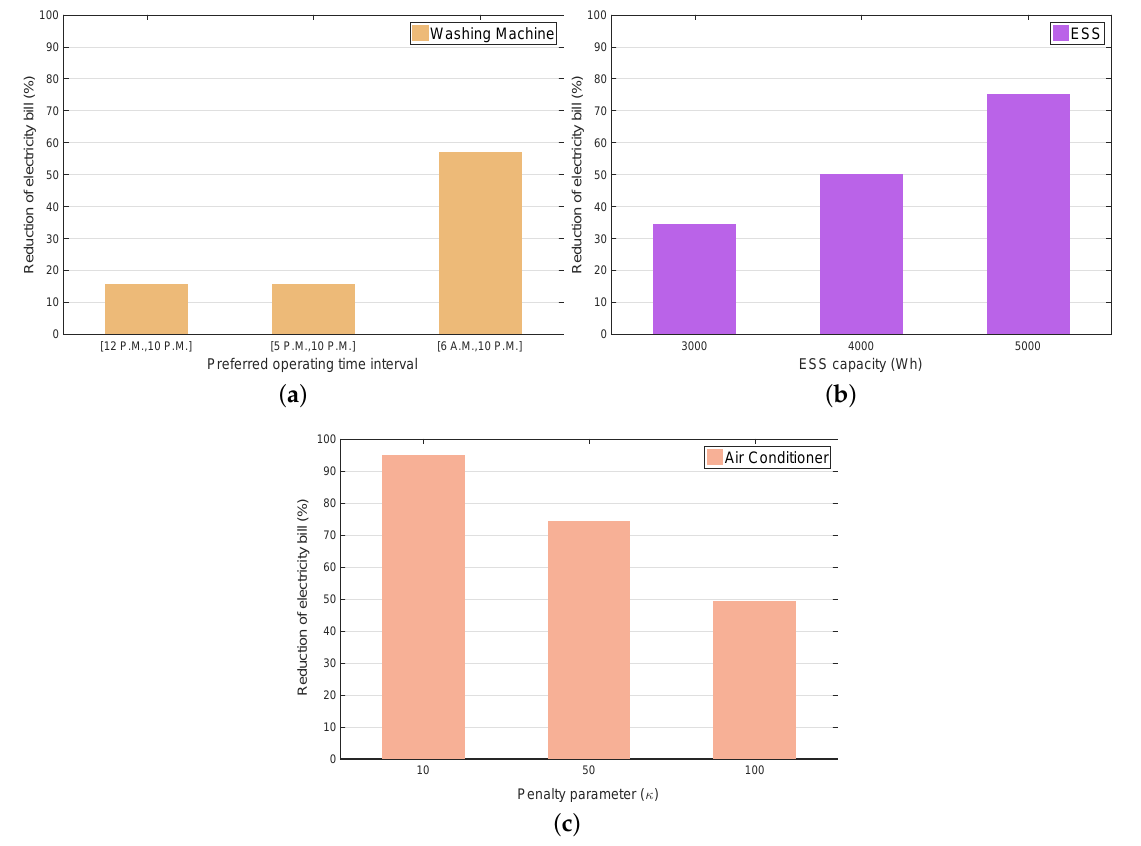
Figure 11. Reduction in electricity bill with different operating conditions of appliances. ( a ) WM under varying preferred operating time intervals; ( b ) ESS under varying capacity; ( c ) AC under varying penalty